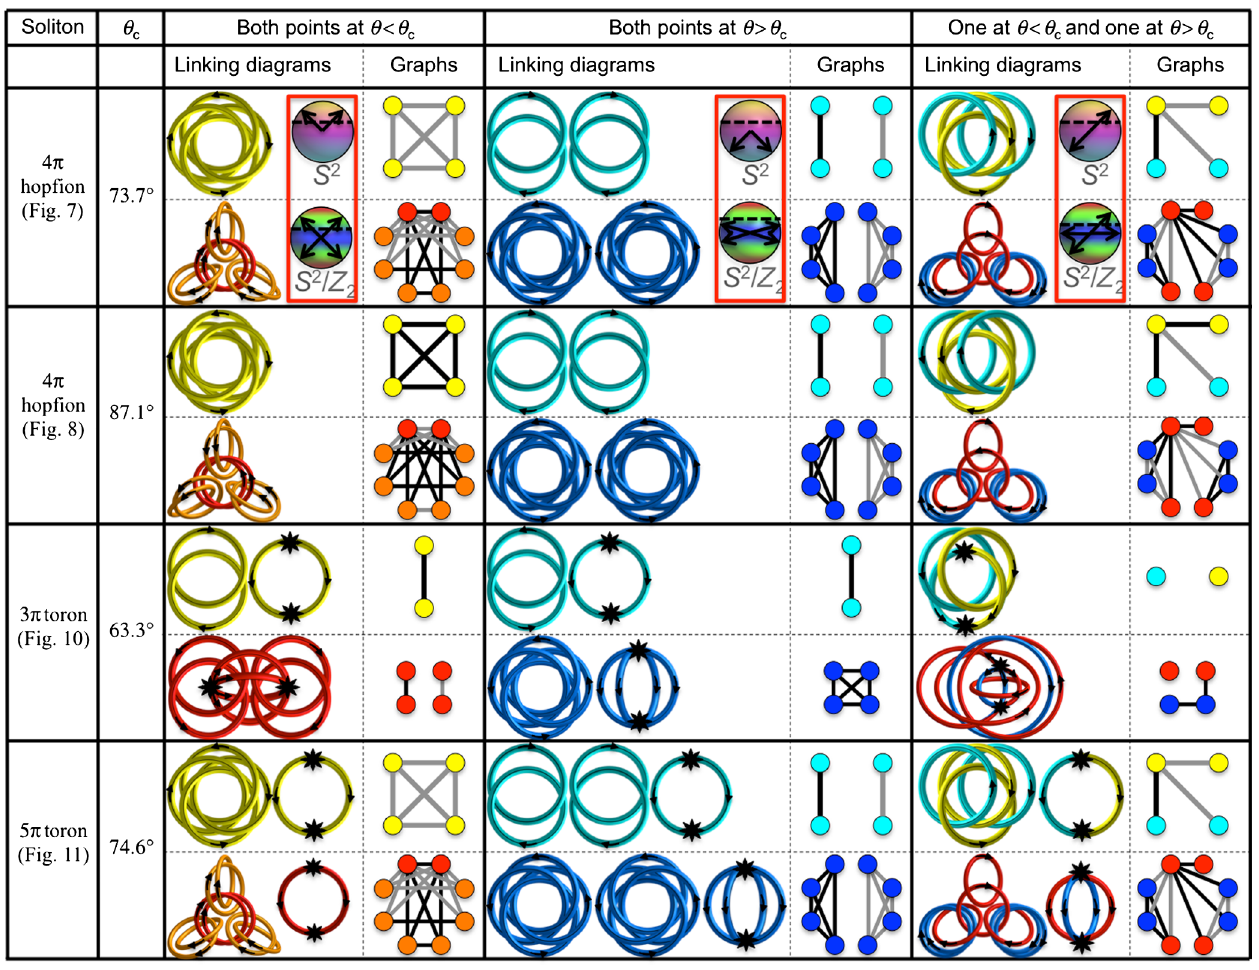
Fig. 9. Linking diagrams and graphs of complex 3D solitons. The figure presents the analysis of linking of preimages of two separate points on S 2 and S 2 =Z 2 for composite 3D topological solitonic field configurations on the basis of both nonpolar and vectorized n ð r Þ of the studied structures. The insets in the red boxes at the top of the columns “ linking diagrams ” depict the order parameter spaces of vectorized (top) and nonpolar (bottom) n ð r Þ , with arrows or double arrows indicating the points for which the preimage linking is analyzed. The dashed lines on the S 2 and S 2 =Z 2 schematics separate the fragments of the S 2 and S 2 =Z 2 with θ < θ c (top parts) and θ > θ c (bottom parts). The locations of the points corresponding to preimages, shown using single and double arrows on are the same for all solitons within the same column. In the graphs, the individual links are indicated by black or gray lines connecting the corresponding colored filled circles that represent closed-loop preimages (the black lines indicate positive signs of linking of preimages as determined by circulations, while the gray lines correspond to the negative ones). The colors of the filled circles are indicative of the points on S 2 (for schematics shown above the horizontal dashed lines of the table) or S 2 =Z 2 (for schematics shown below the horizontal dashed lines of the table); for n ð r Þ at θ < θ c , two out of eight filled circles of the graphs are shown as red and the rest as orange to distinguish them on the basis of the number of times the corresponding preimages are linked. The mutually linked preimage rings in the simplified topology presentations are also shown in colors corresponding to their locations on S 2 or S 2 =Z 2 and have arrows denoting circulation consistent with the far-field preimage. The point defects of torons within the topological skeletons are shown using black stars. Both the topological skeleton and graph representations of the preimage structures are constructed for the same solitonic field configurations and are provided next to each other for the case of vectorized n ð r Þ